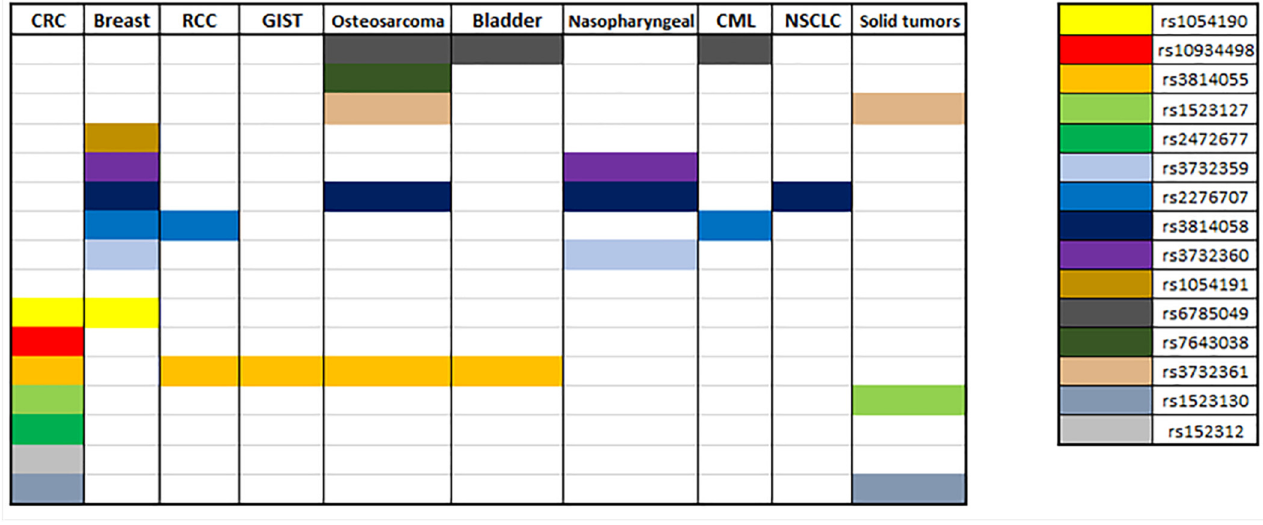
Figure 4. Summary of correlations of NR1I2 polymorphisms with different types of cancer. Table 1. PXR polymorphisms and their associations with efficacy, toxicity and pharmacokinetics of chemotherapeutic agents.